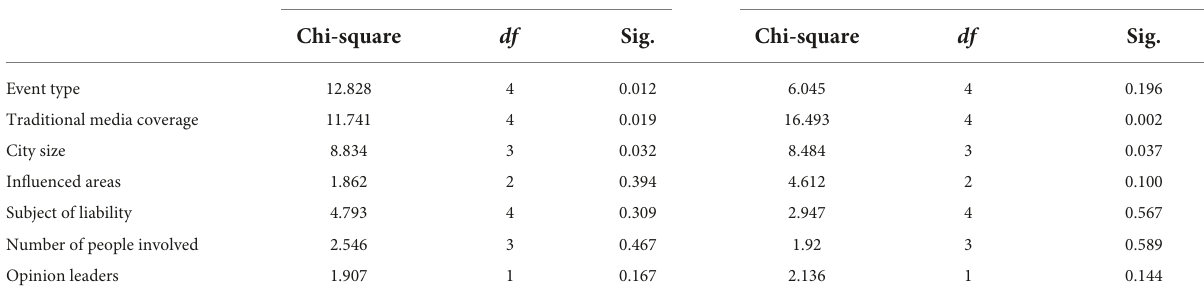
TABLE 5 Log Rank and Breslow